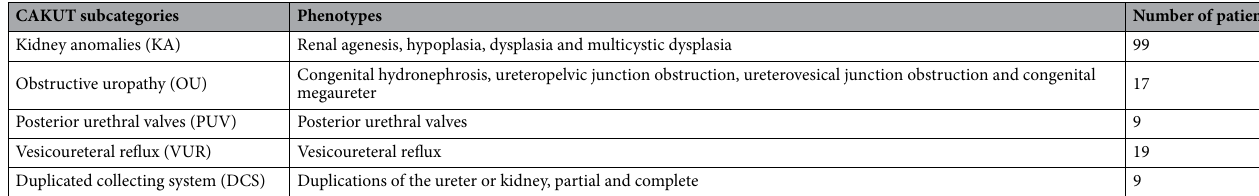
Table 1. Phenotypes of patients, in which rare pathogenic or likely pathogenic CNVs have been identified, included in the estimation of most frequently affected miRNAs. Data extracted from Verbitsky et al., 2019 study 4 .